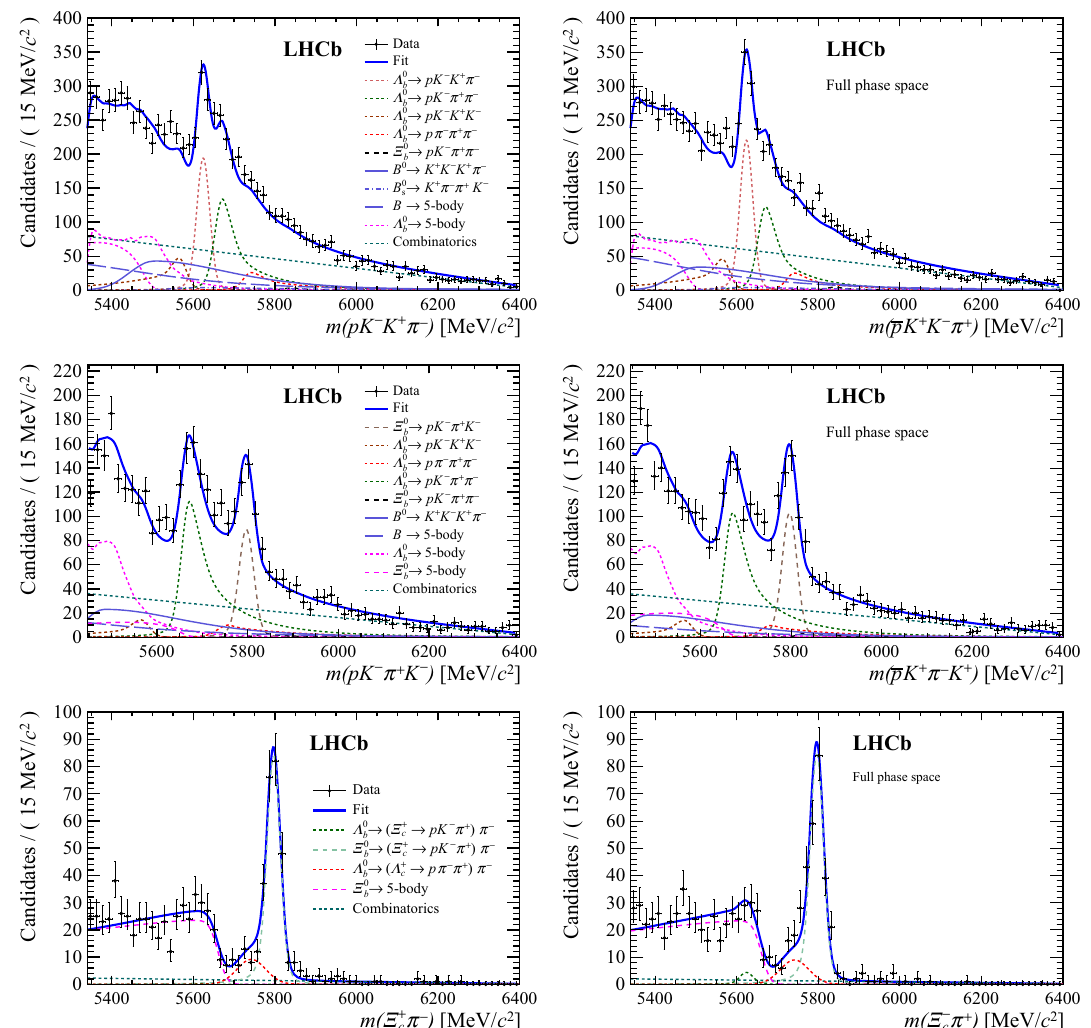
Fig. 7 Invariant(firstrow) pK − K + π − and(secondrow) pK − π + K − massdistributions,withtheresultsofthefitsuperimposed. Thetwobot- tom plots are the results of the fit to the Ξ 0 control channel. The two columns correspond to the charge-conjugate final states: (left) baryon, (right) antibaryon. The different